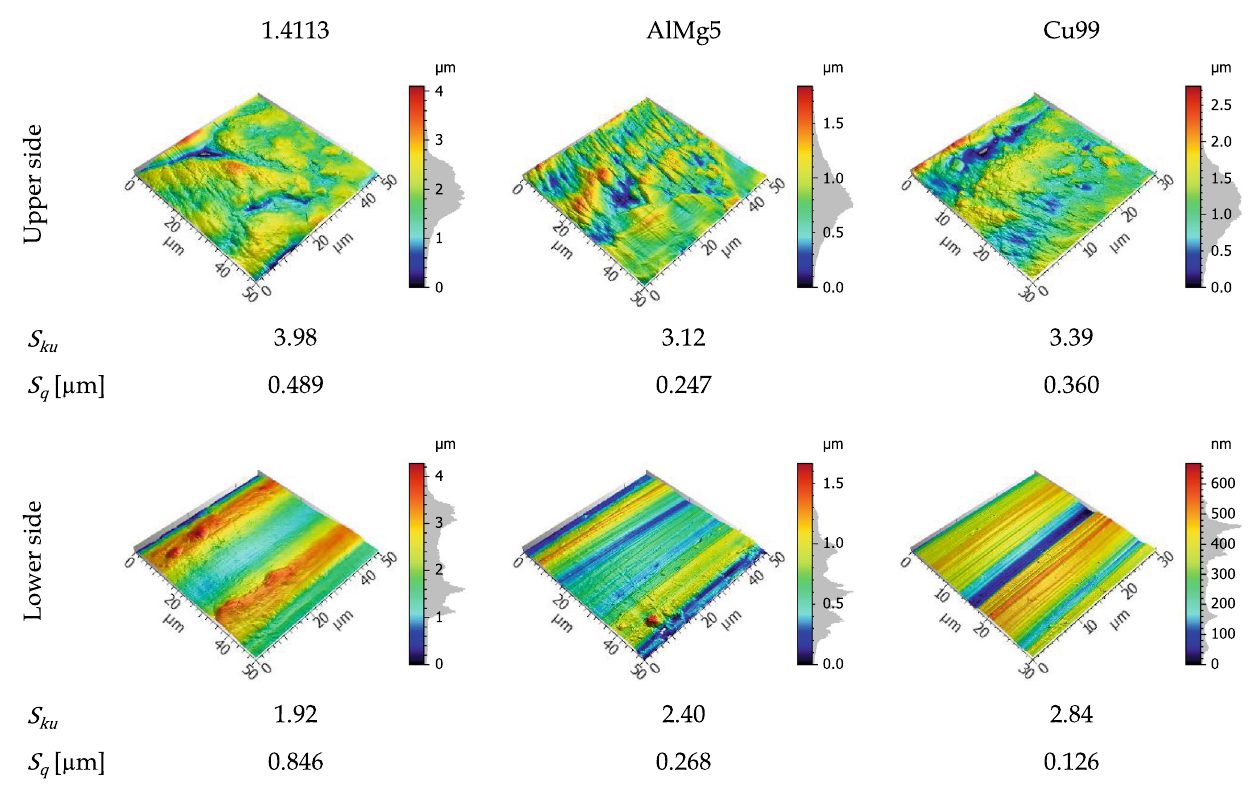
Fig. 8 AFM analysis of metal staple fibres 1.4113 (a), AlMg5 (b) and Cu99